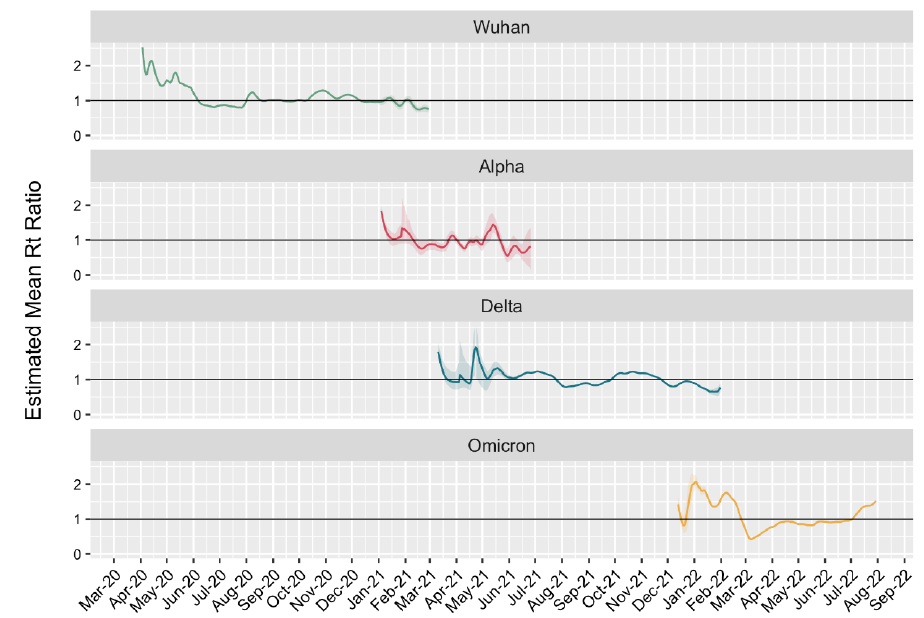
Figure 4. Change dynamics of Rt for main SARS-CoV-2 genetic lineages.